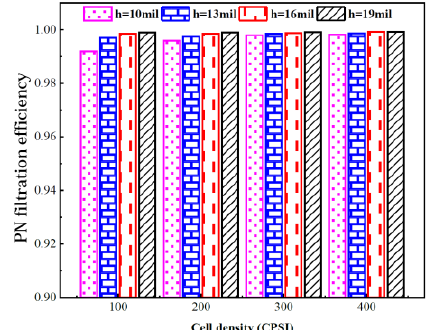
Fig. 9. Influence of the DPF cell density and wall thickness on the PN filtration efficiency under certain